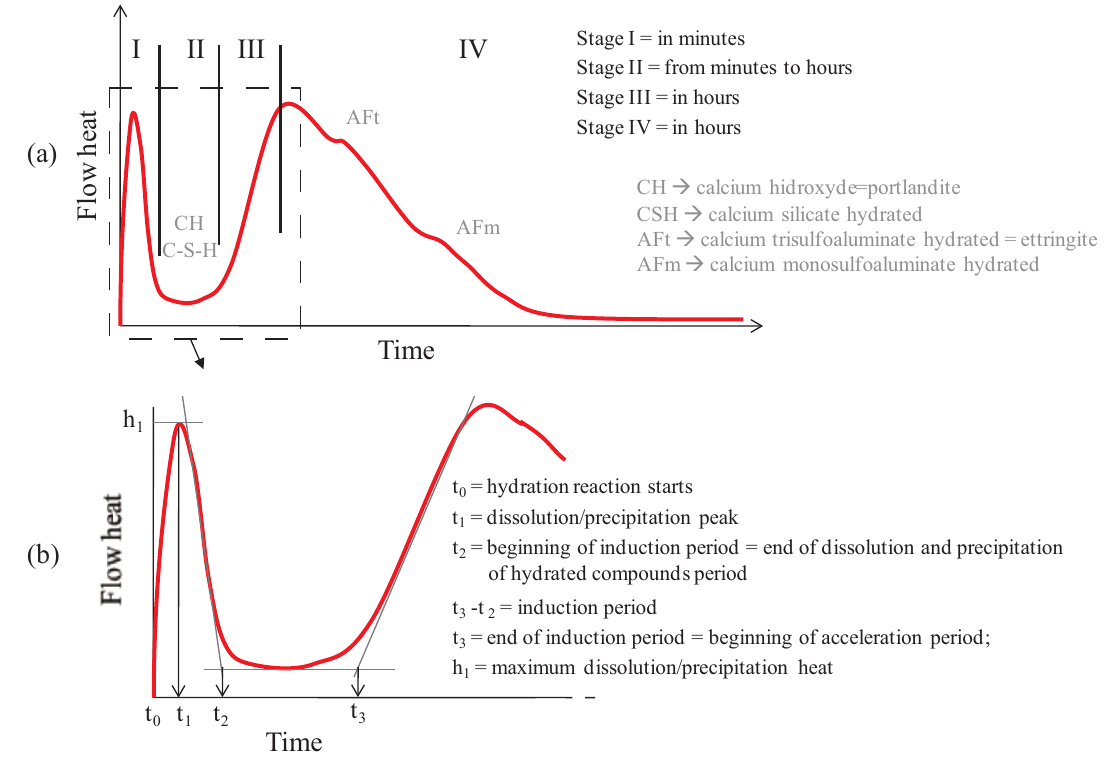
Illustration of the heat release in function of time. In (a), the flow heat divided in four stages is presented and in (b) what each point